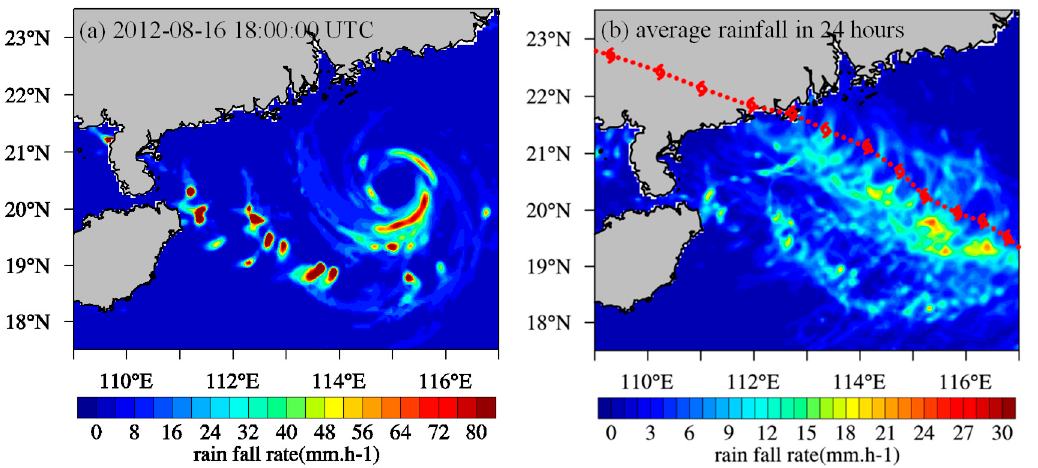
Figure 8. Spatial distribution of instantaneous and average precipitation influenced by typhoon Kai-tak from August 16 to August 17, 2012.